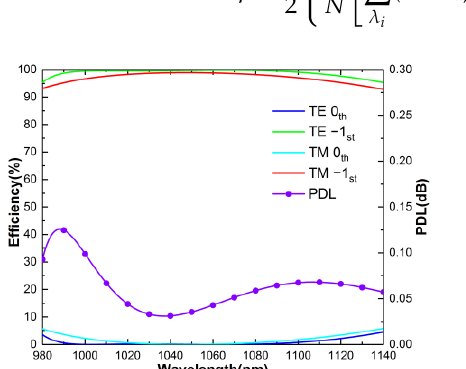
Figure 3. Diffraction efficiencies of − 1st and 0th orders for TE and TM polarizations and the PDL of the designed grating.